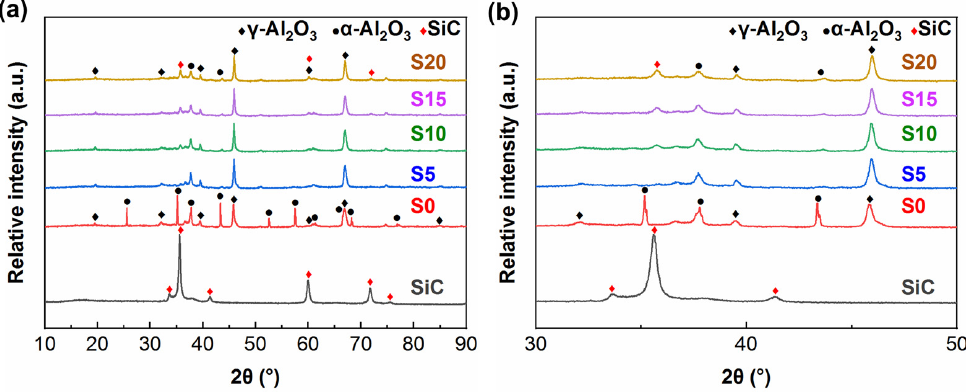
Figure 2. XRD patterns of CPED coatings: ( a ) 10°~90°; ( b ) 30°~50°.